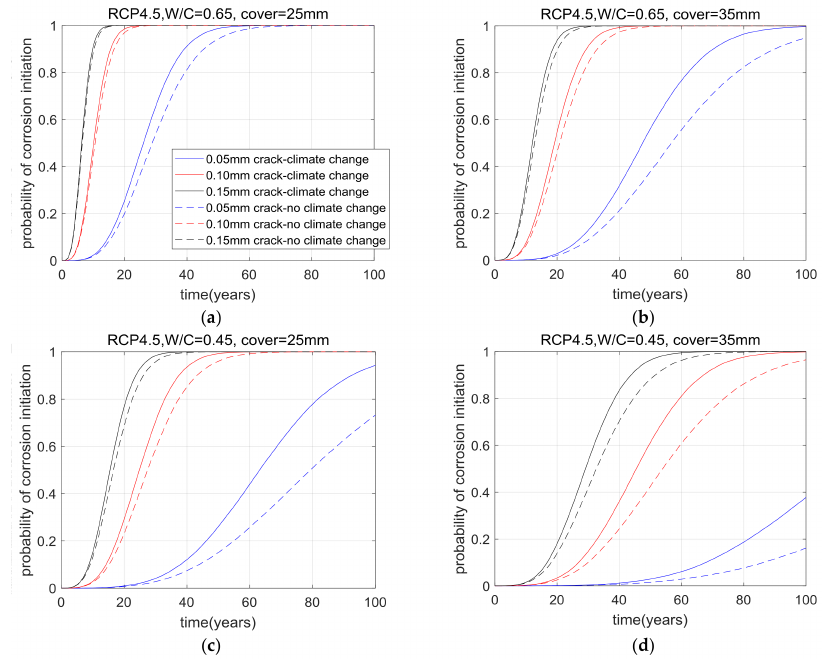
Figure 9. Probability of corrosion initiation-RCP 4.5, time slice 2000. ( a ) W/C: 0.65, Cover depth: 25 mm; ( b ) W/C: 0.65, Cover depth: 35 mm; ( c ) W/C: 0.45, Cover depth: 25 mm; ( d ) W/C: 0.45, Cover depth: 35